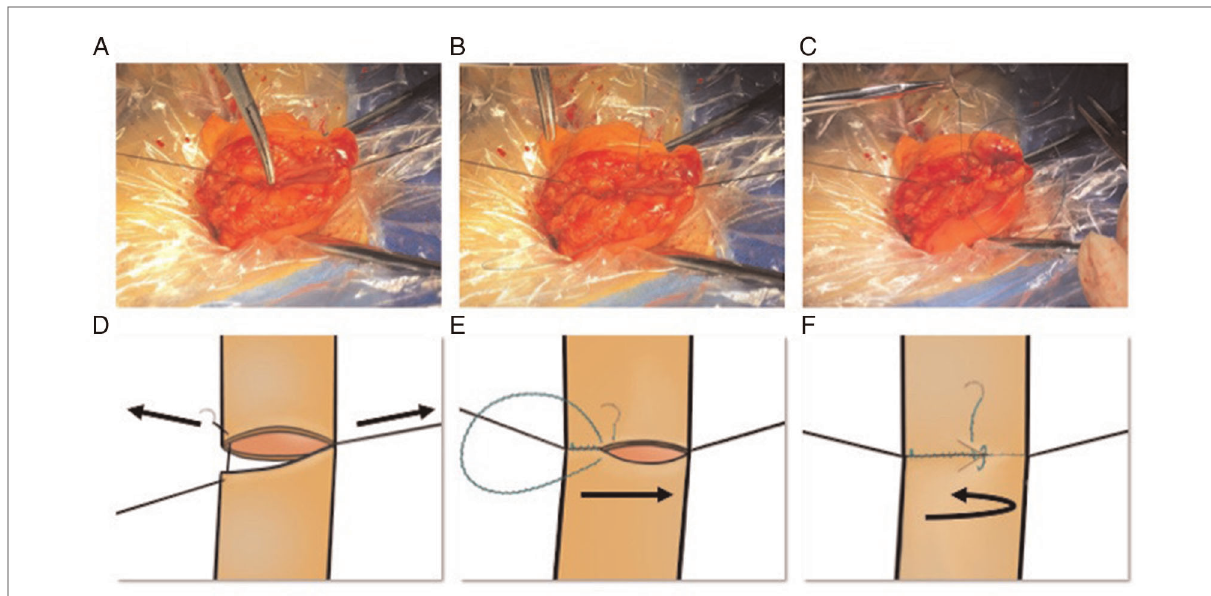
FIGURE 3 Intraoperative photograph and schematic illustration of KHEA. ( A,D ) Colon suspension: identi fi cation of the mesenteric and the mesangial borders of the two colonic extremities, suspended with single-strand sutures. These two threads are used to maintain tension and lift the bowel. ( B,E ) Inner layer suture: We use barbed suture to perform continuous full-thickness suture from the opposite mesangial to the mesenteric border. Suture bites are placed 3 – 5 mm apart and 2 – 3 mm from the cut edge of the tissue. ( C,F ) Outer layer reinforcement: We continuously suture the serosa from the mesangial to the mesangial border. Suture bites are placed 5 mm apart and 5 mm from the line of anastomosis. The outer layer suture completely buries the inner suture. KHEA, knotless hand-sewn end-to-end